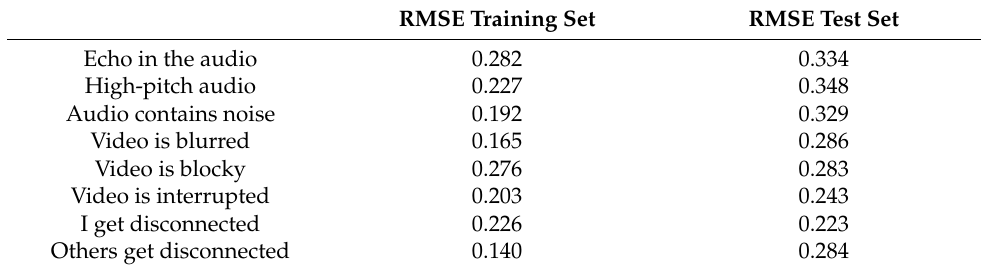
Table 15. RMSE values for the two data